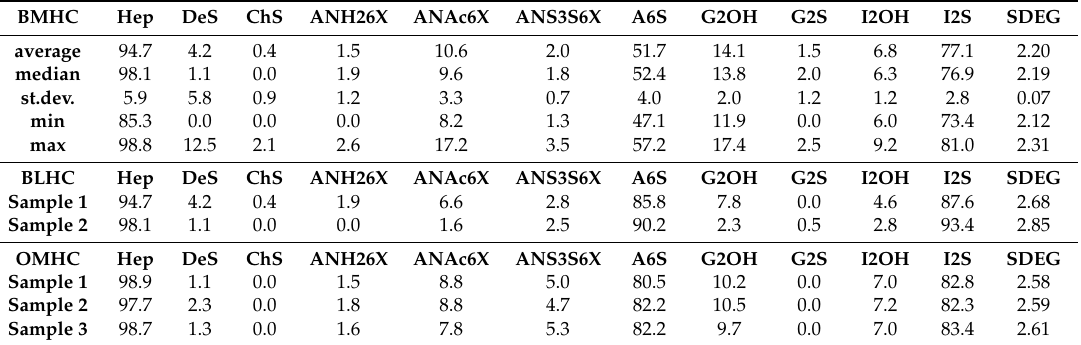
Table 3. Molar average composition of crude heparin of different species/organ.